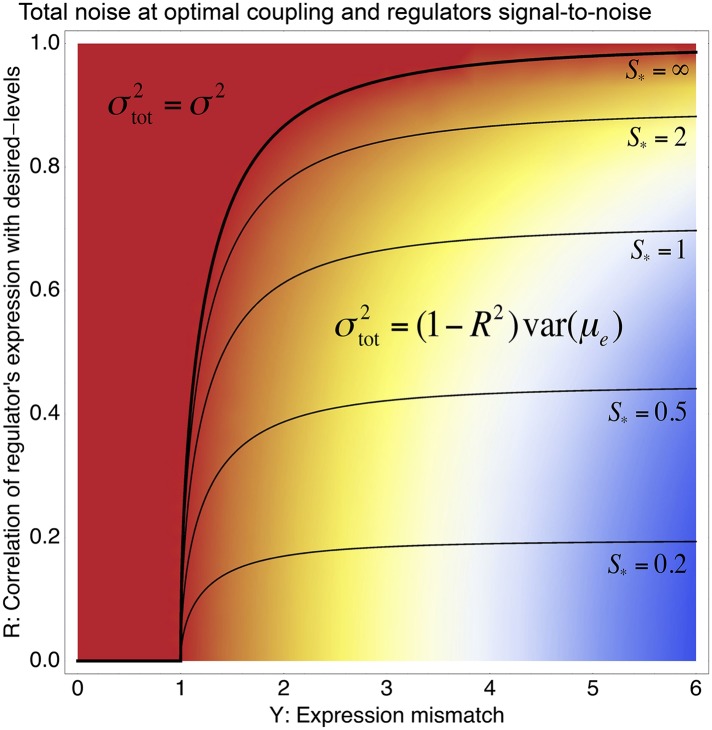
Phase diagram of the total noise σtot of a promoter with expression mismatch Y (horizontal axis) that is coupled (at optimal coupling strength) to a regulator whose regulatory activities have correlation R with the desired expression levels (vertical axis) and whose signal-to-noise ratio S has also been optimized.The colors indicate the value of σtot, running from σtot equal to the noise σ of the unregulated promoter (red) to σtot = 6σ (blue). A phase boundary (thick black curve) separates solutions in a ‘basal noise regime’ at the top left, where the total noise equals the minimal noise σ2, and solutions in an ‘environment-driven noise regime’ at the bottom right, where the total noise matches the variance in desired levels that is not tracked by the regulation, that is, σtot2=(1−R2)var(μe)−τ2. The contours show optimal signal-to-noise ratios S* as a function of Y and R. Note that S* diverges at the phase boundary.